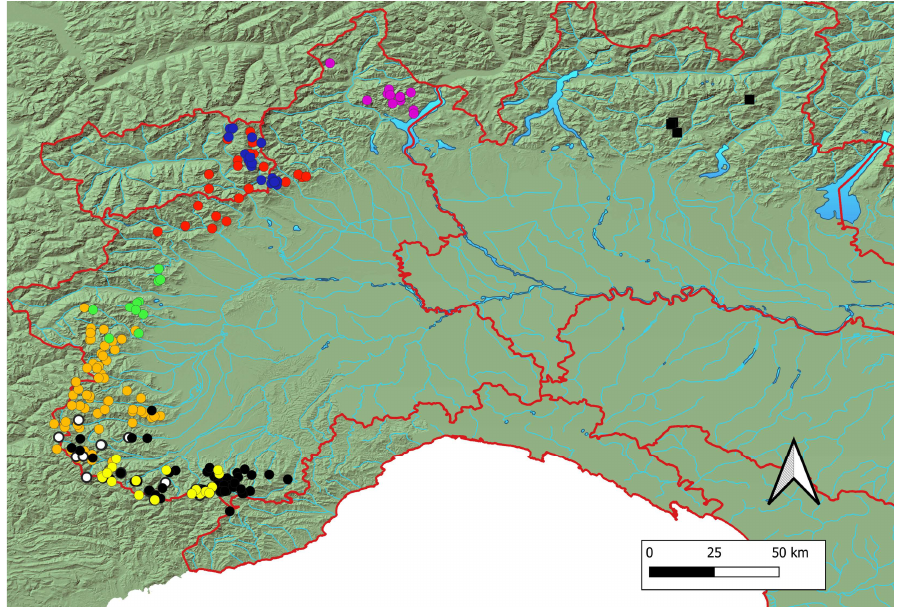
Figure 2. Distribution map of the Platynus species: black dots = P. maritimus n. sp. ; white dots = P. occitanus n. sp. ; yellow dots = P. peirolerii ; orange dots = P. erythrocephalus ; green dots = P. simonisi n. sp. ; red dots = P. complanatus ; blue dots = P. depressus ; violet dots = P. vignai n. sp. ; black squares = P. teriolensis .